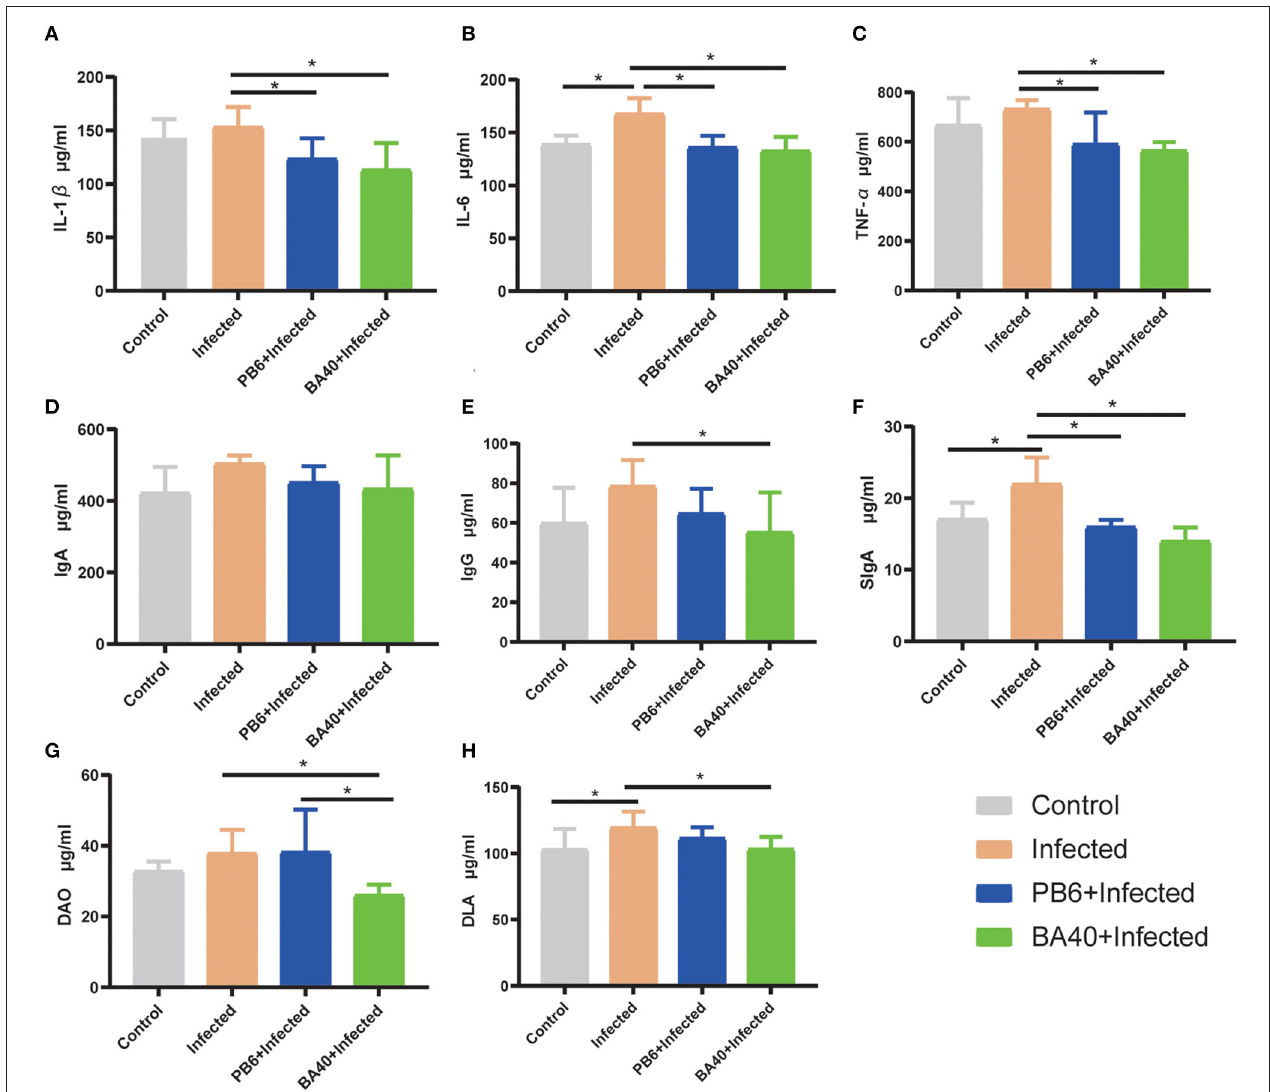
FIGURE 4 | Effect of BA40 treatment on DAO, DLA, and inflammatory cytokines of mice. (A) IL-1 β ( n = 6) concentrations. (B) IL-6 ( n = 6) concentrations. (C) TNF- α ( n = 6) concentrations. (D) Immunoglobulin A (IgA) ( n = 6) concentrations. (E) Immunoglobulin G (IgG) ( n = 6) concentrations. (F) Secretory Immnoglobulin (SIgA) ( n = 6) concentrations. (G) Diamine oxidase (DAO) ( n = 6) activity. (H) D-lactate (DLA) ( n = 6) concentrations. Results are presented as mean ± SD (*represented significant differences, P <